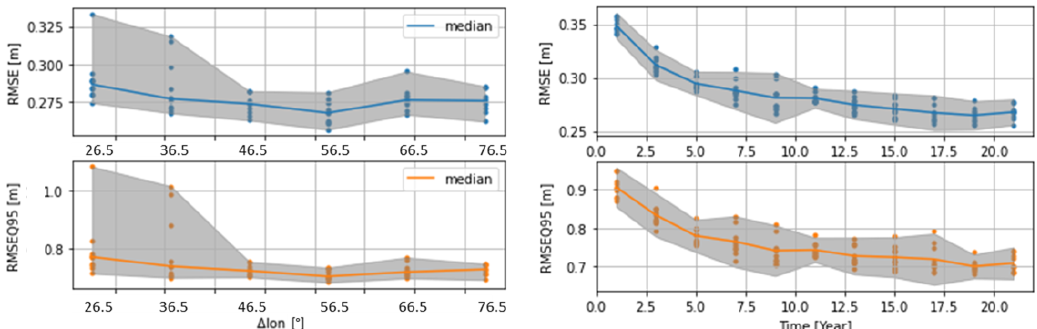
Figure 9. RMSE and RMSEQ95 versus (cid:49) longitude (left). RMSE and RMSEQ95 function of (cid:49) time